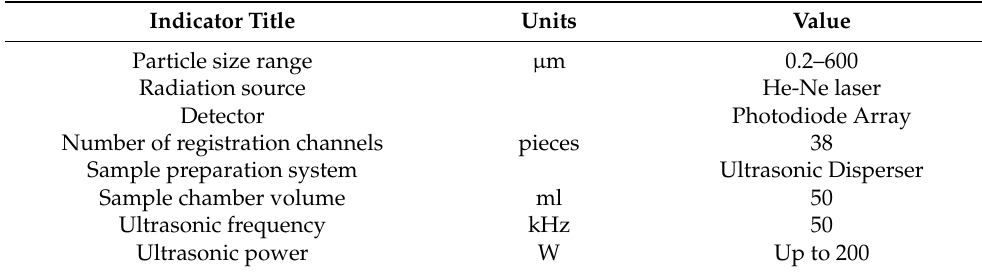
Table 9. Technical characteristics of Microsizer 201C.